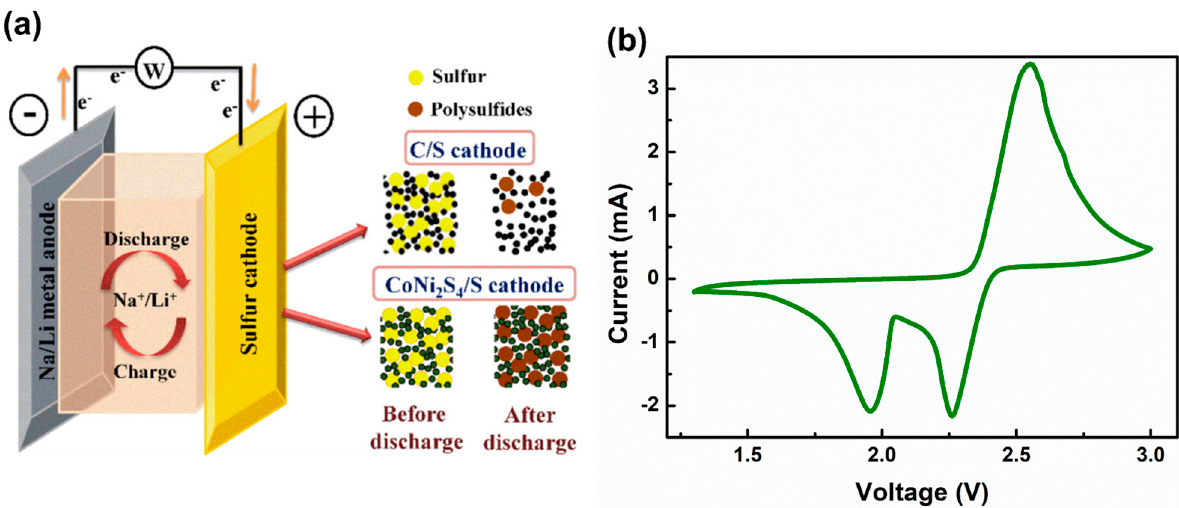
Figure 1. ( a ) Schematic representation of Li-S battery comprising two different cathode (C/S and CoNi 2 S 4 /S), lithium metal as the anode and ether-based electrolyte, ( b ) A cyclic voltammetry diagram of a liquid electrolyte-based Li-S cell with conventional C/S cathode. (Reprinted with permission from [41]); Copyright 2020, ACS Appl. Mater. Interfaces 2020 , 12 , 25, 28120–28128.)